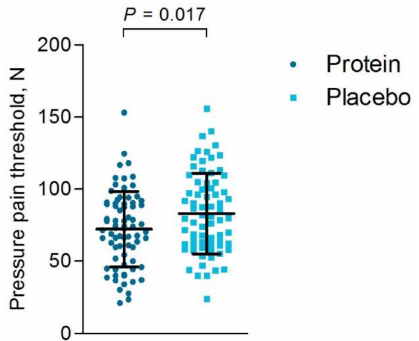
Figure 4. Pressure pain thresholds one and two days post-race in N (newton). The pressure pain thresholds are shown for the protein group ( • dark blue circles) and the placebo group ( (cid:4) light blue squares) with the mean and standard deviation (SD), based on intention-to-treat analysis. Within the protein group significantly lower pressure thresholds on the quadriceps could be endured compared to the placebo group, representing higher quadriceps soreness compared to the placebo group ( p =